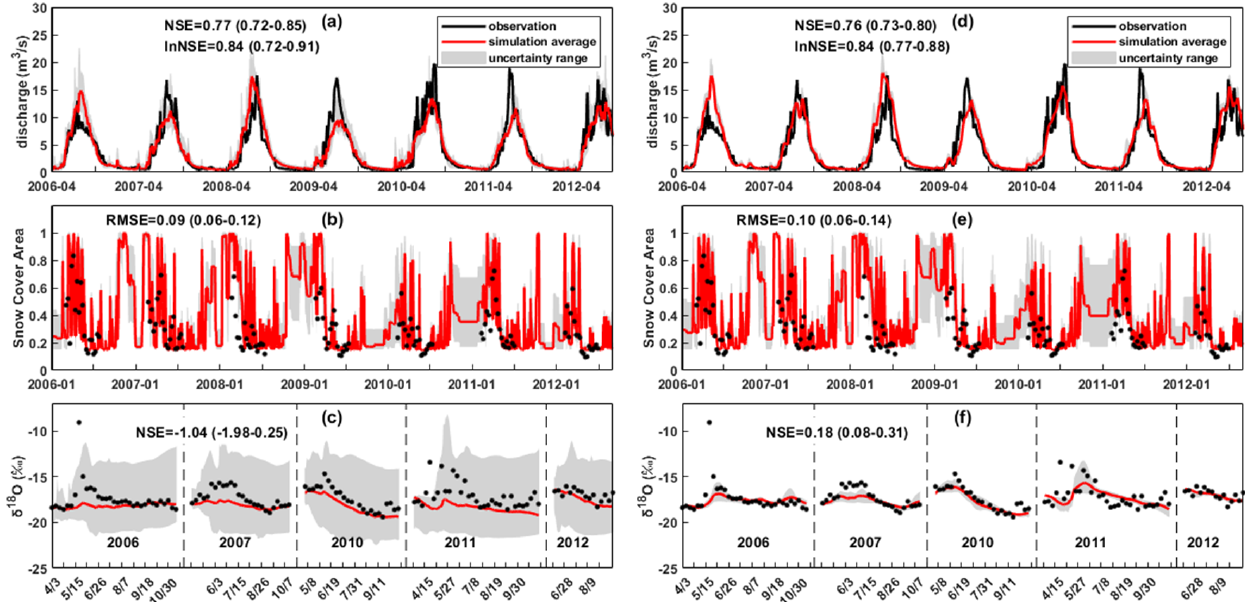
Figure 4. Uncertainty ranges and metrics values of the simulated discharge, SCA, and stream δ 18 O in the KR catchment produced by the behavioral parameter sets of a bi-objective calibration (a–c) and a tri-objective (d–f) calibration in the benchmark model